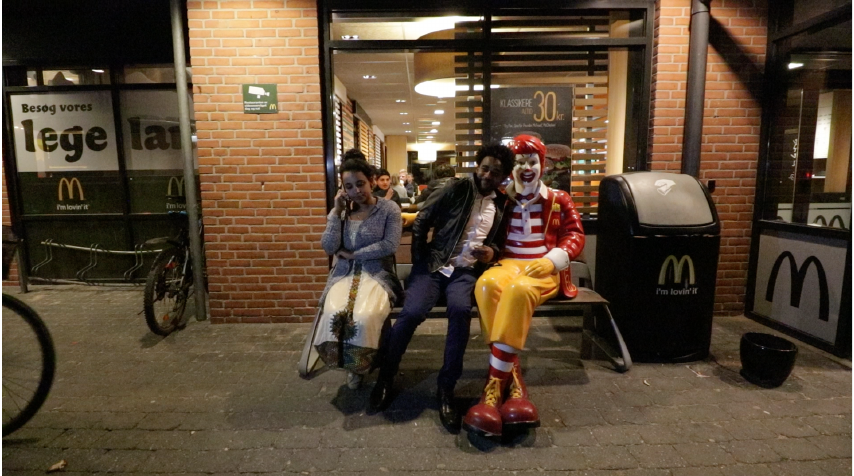
Figure 24. After celebrating Good Friday, the whole community went to get a snack at McDonald’s. John poses with Ronald McDonald, while his sister Habtom is on the phone with their family. April